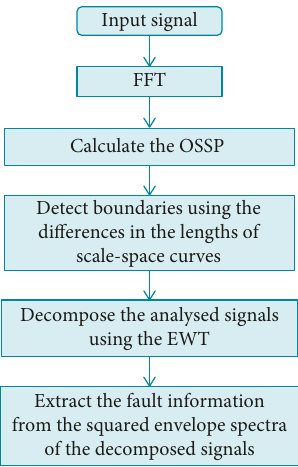
Figure 10: The procedure of the proposed